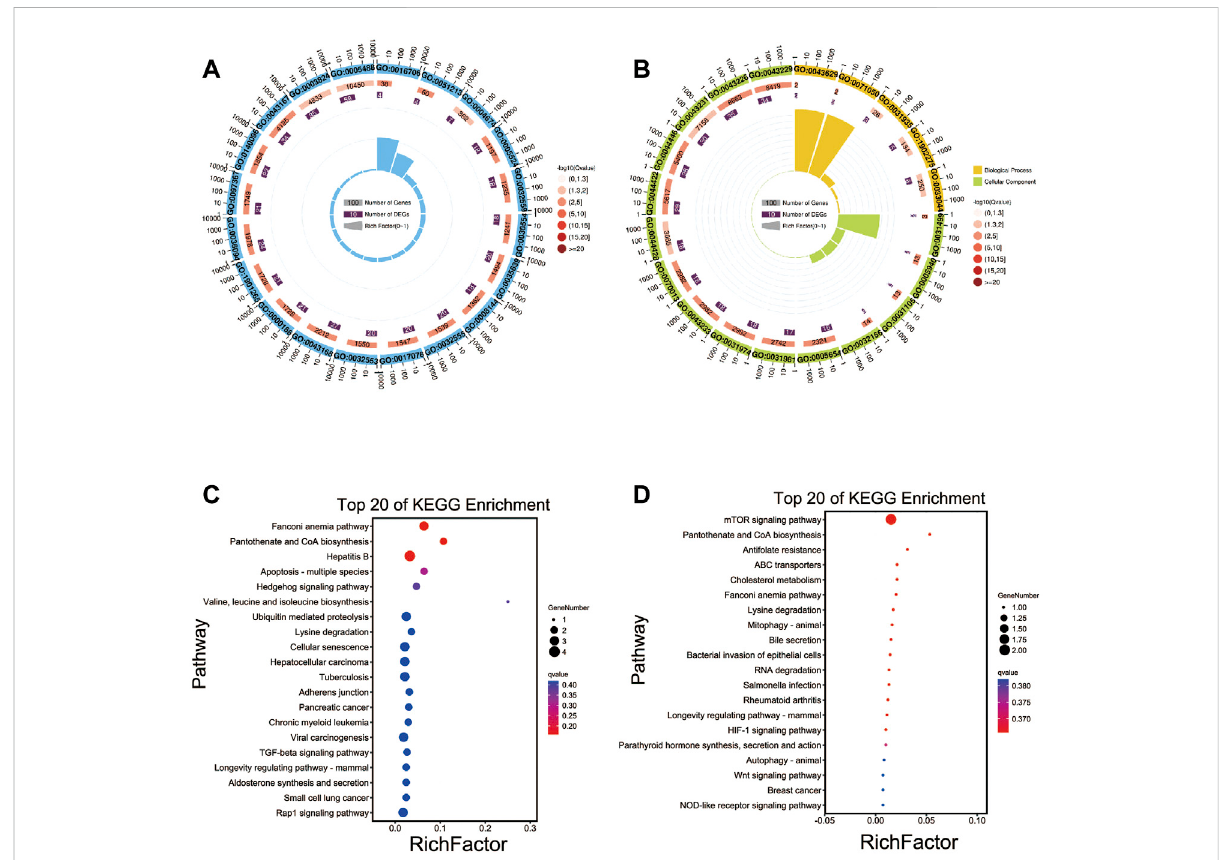
FIGURE 4 Functional annotation analysis of the source genes of DEcircRNAs. (A) GO annotation of the source genes of DEcircRNAs between TN and TL groups. (B) GO annotation of thesource genes of DEcircRNAs between LN and LL groups. (C) KEGG enrichment of the source genes of DEcircRNAs between TN and TL groups. (D) KEGG enrichment of the source genes of DEcircRNAs between LN and LL